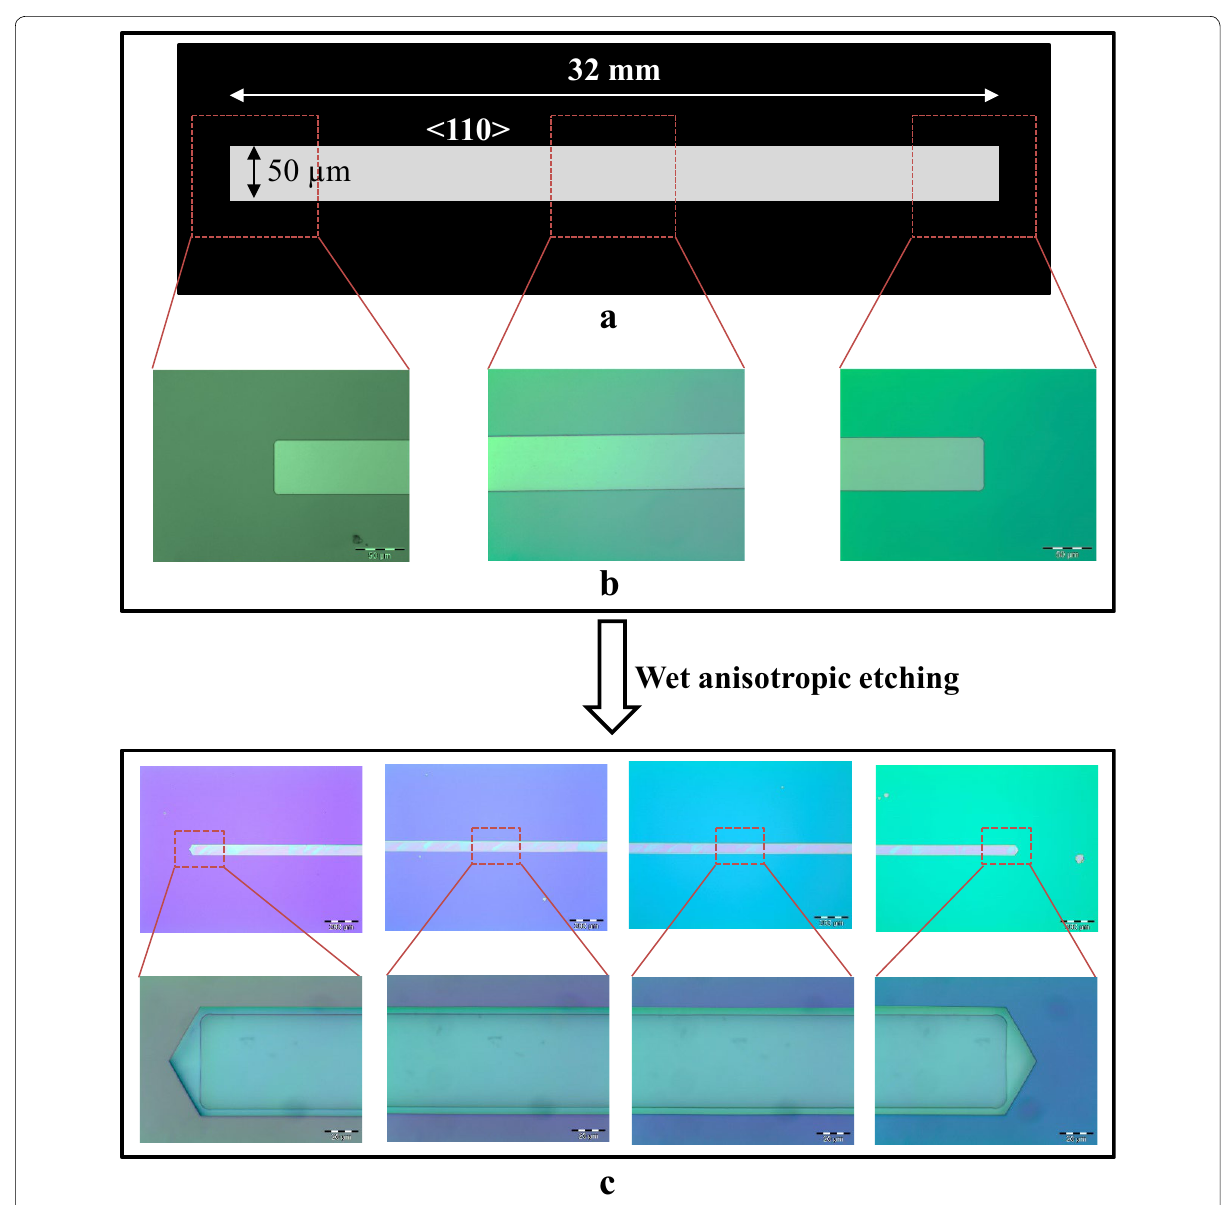
Fig. 6 A 50 μm wide and 32 mm long rectangular shape mask opening with longer edge aligned along the 〈 110 〉 direction on {111} wafer surface to test the accuracy of proposed method: a schematic diagram, b optical image of the mask pattern after oxide etching, c etched profile with zoomed-in images of different portions. Pre-etched patterns are used as reference for the precise alignment of the mask edges along 〈 110 〉 direction. The undercutting at the mask edges takes place due to finite etch rate of {111} plane and the uniform undercutting indicates the accurate alignment of mask edges along 〈 110 〉